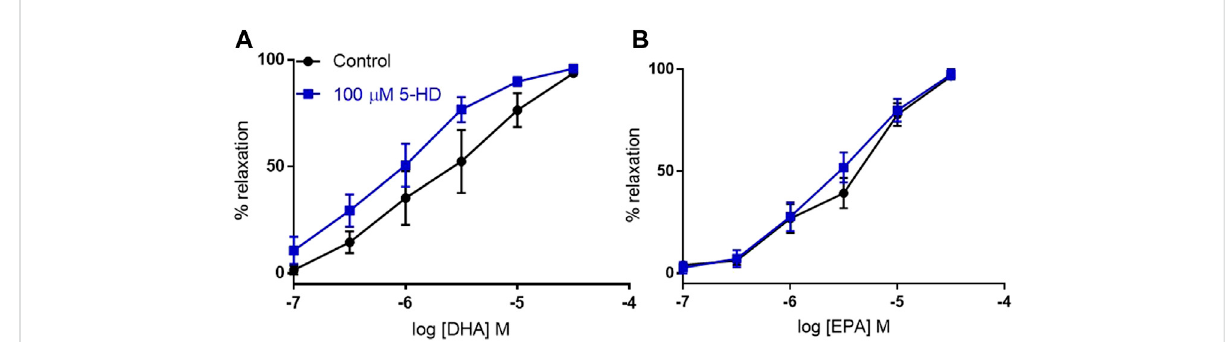
FIGURE 6 The effects of inhibition of mitochondrial K ATP channels on n-3 PUFA-induced relaxation in mouse aortic rings preconstricted with U46619. (A) DHA- and (B) EPA-induced relaxation in mouse aorta following treatment with the selective mitochondrial K ATP inhibitor 5-HD (100 µM) compared with untreated rings from the same animal. n = 5, data represented as mean ± SEM. * p < 0.05, signi fi cant difference from control curve assessed by two way ANOVA followed by Bonferroni multiple comparison